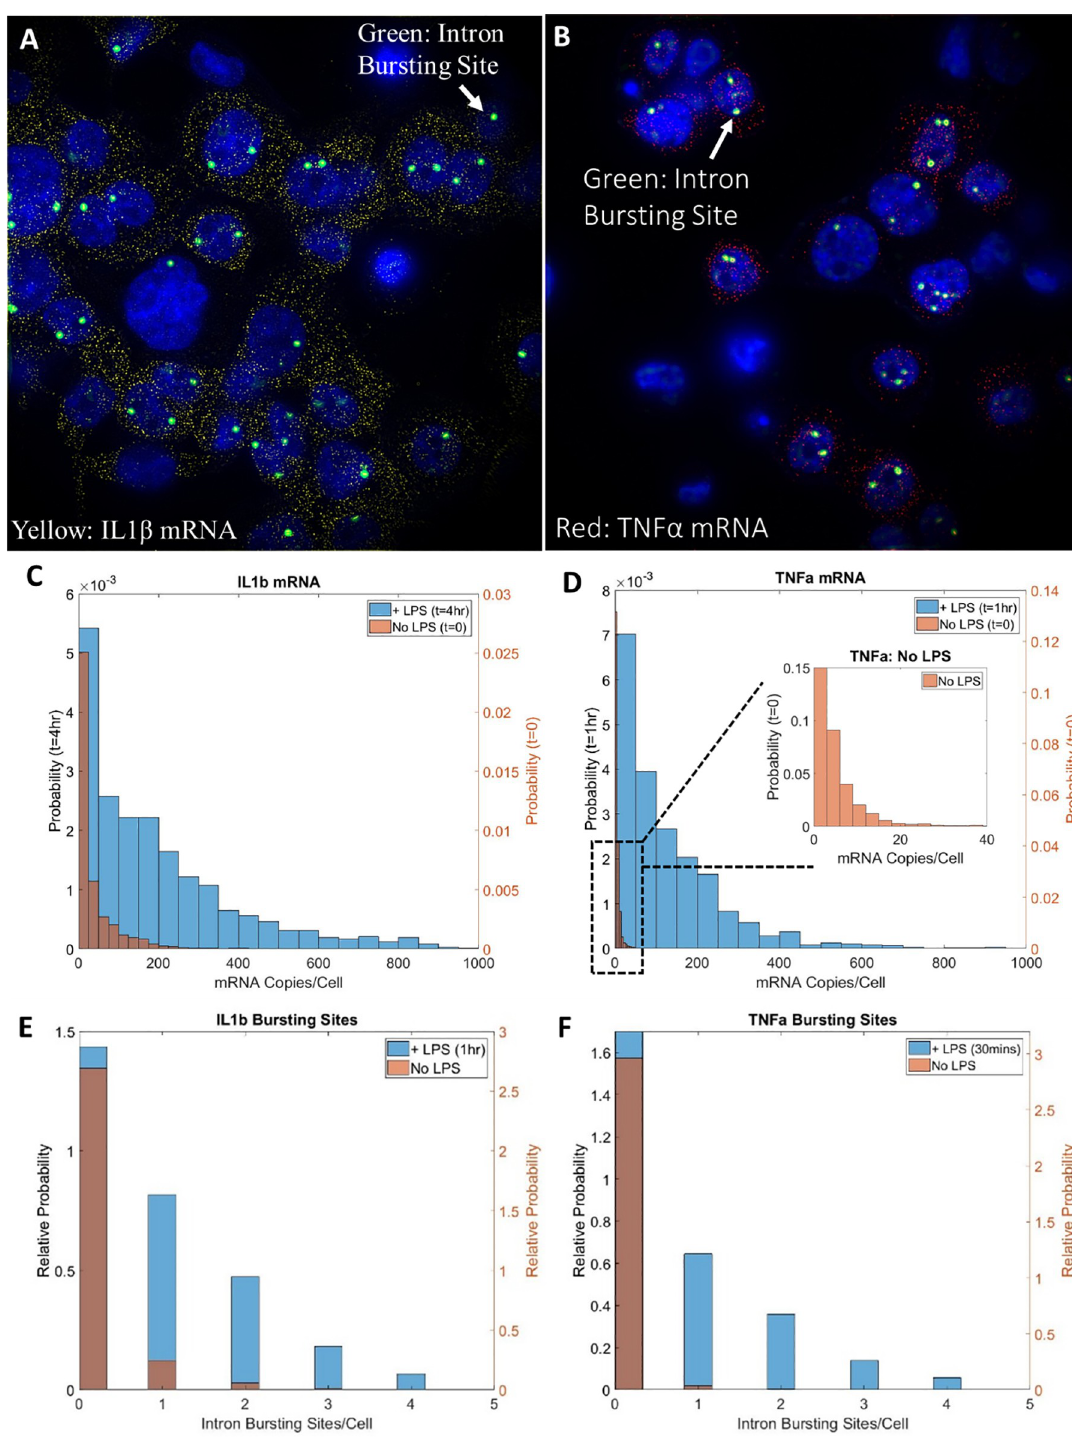
Fig 2. Single-cell gene expression of IL1 β and TNF- α . Example images of mRNA (small yellow/red spots) and intron bursting site data (large green spots) for IL1 β (A) and TNF- α (B) after 1hr of LPS stimulation overlaid with nuclear content (DAPI, blue). Each small yellow spot is a single IL1 β mRNA, each red spot is a single TNF- α mRNA, while each large green spot is an intron bursting site where many (~100) copies of IL1 β are being actively transcribed. Distributions of single-cell mRNA counts for IL1 β (C) and TNF- α (D) are upregulated with the addition of LPS. Intron bursting site distributions are also upregulated following the addition of LPS for both IL1 β (E) and TNF- α (F). Note that cells identified with 3 or 4 intron bursting sites result from errors in cell segmentation or come from cells that are undergoing